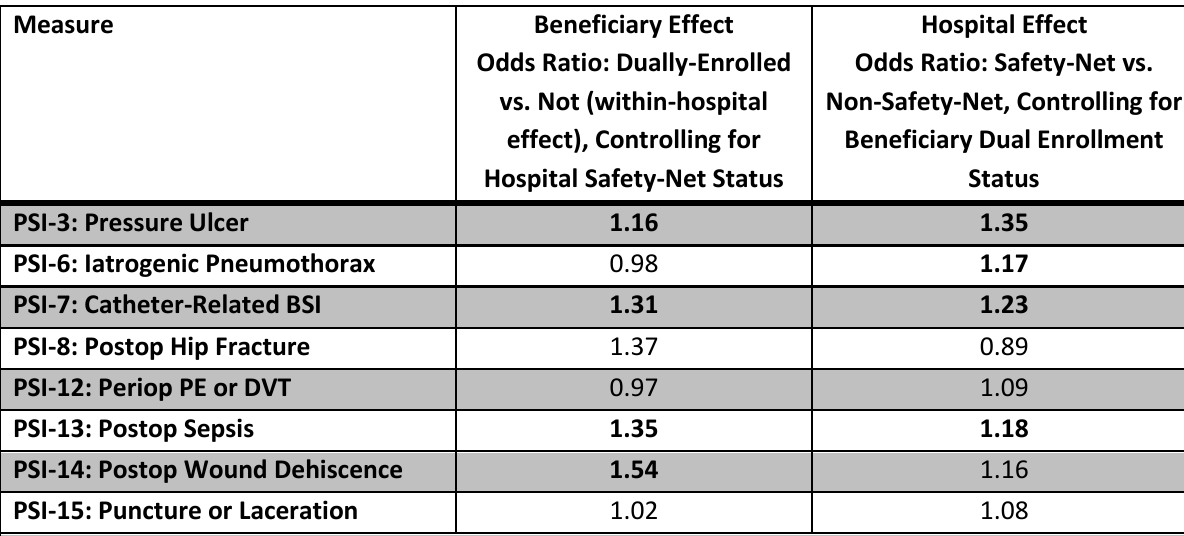
Table 6.7: Relationships with PSI-90 Components: Patient Social Risk (Duals) and Safety-Net Hospital Status in Single